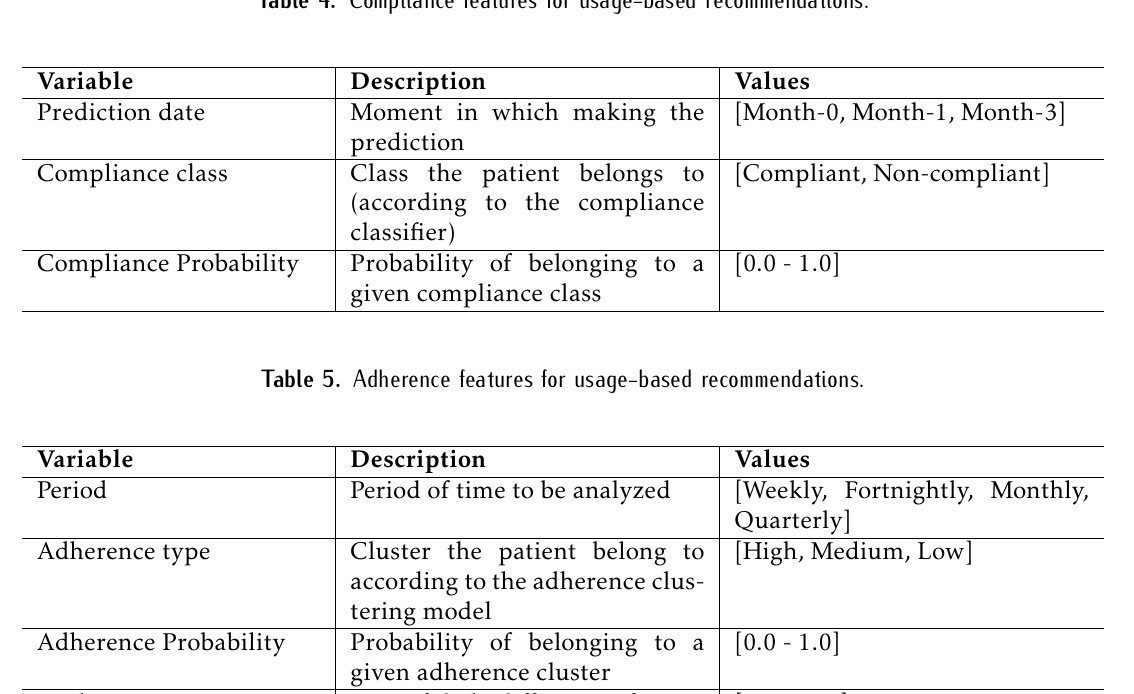
Table 4. Compliance features for usage-based recommendations.